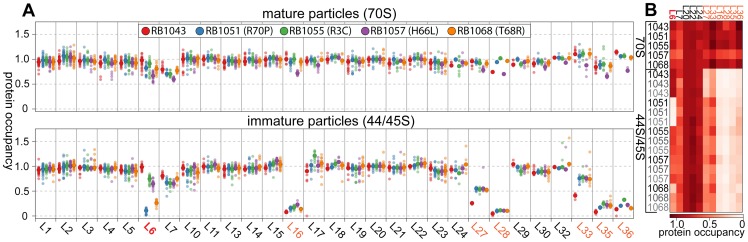
Protein composition of 44S and 45S particles. (A) Ribosomal protein occupancy in 70S (top) or 44S/45S (bottom) samples.Protein occupancy is reported as the corrected 14N/15N ratio. To account for differences in the amount of sample analyzed, for each peptide, this ratio is normalized to the median calculated ratio for L20, a protein bound stoichiometrically in all samples. Each sample bore the RbgA F6A mutation as well as additional L6 mutations as noted in the legend. Semitransparent dots represent individual peptide measurements. The median value is indicated with a larger opaque marker. Protein L6 is highlighted in red. Proteins significantly depleted are colored orange. (B) Replicate analysis of selected ribosomal protein occupancy. Median protein occupancy values are reported as a heat map for either 70S or 44S/45S samples, which were analyzed in triplicate using independent biological samples. Protein occupancy ranging from 0 to 1.1 is colored white to red. Row labels are color coded by replicate (black to grey). Column labels are colored as described above.